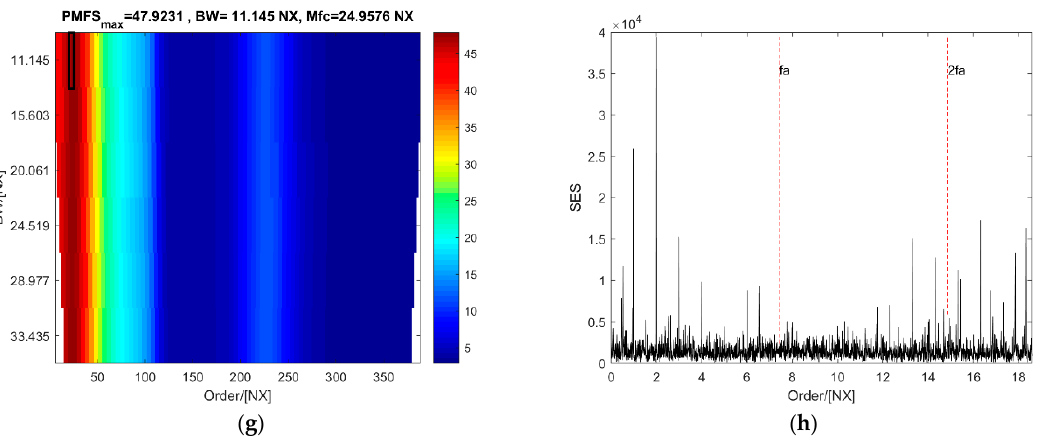
Figure 14. The analysis results of the case of roller defect with a constant speed: ( a , b ) the protugram and the SES of its optimal order band; ( c , d ) the PMgram and the SES of its optimal order band; ( e , f ) the enhanced kurtogram and the power spectrum of its optimal order band; ( g , h ) the PMFSgram and the SES of its optimal order band.